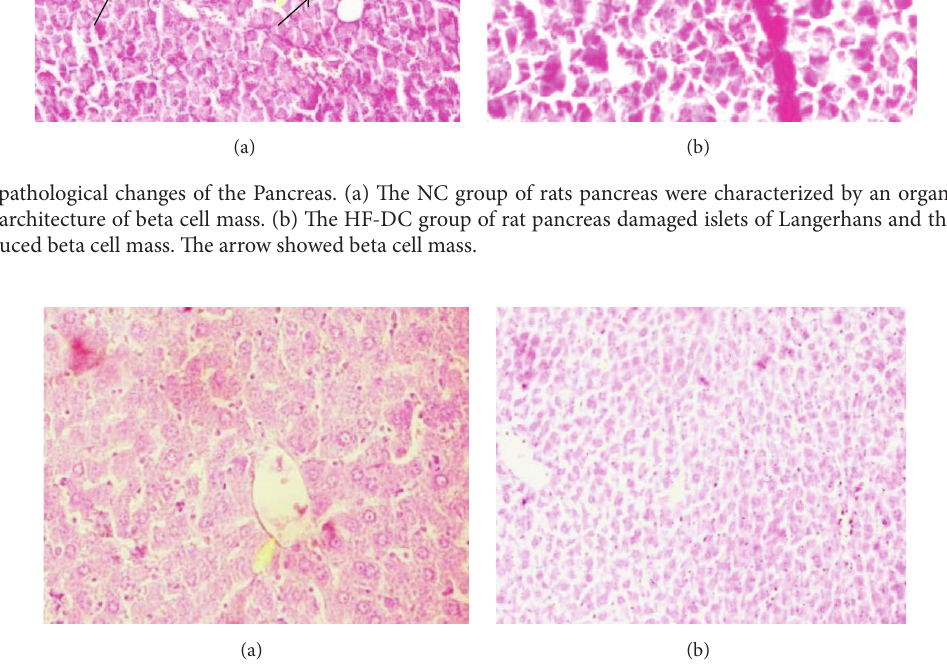
Figure 8: Histopathology of the liver. (a) The liver of the NC group rats shows normal architecture of central vein, peripheral vein, and hepatocytes. (b) The HF-DC group showed degeneration of hepatocyte and congestion in